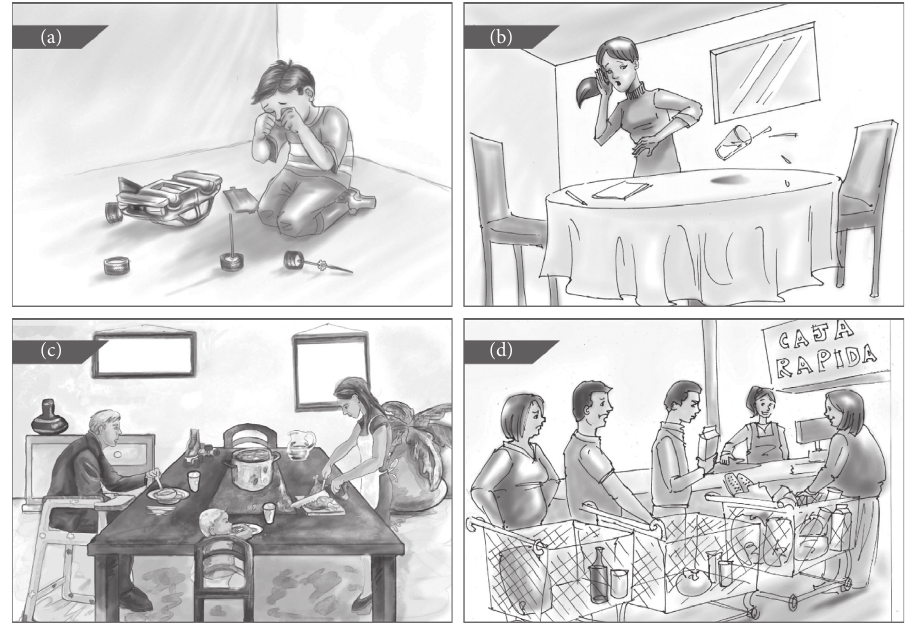
Figure 1: Examples of the COGSOC illustrations used in the causal relationships comprehension, absurdity identification, and social judgment ability subtests. The illustrations presented to patients are in color. (a) Causal relationships comprehension part A-causes: participants are asked “what has most probably happened immediately before this scene?” (b) Causal relationships comprehension part B- consequences: participants are asked “what has most probably happened immediately after this scene?” (c) Absurdity identification: participants are requested to find everything they consider wrong, nonsensical, or absurd. (d) Social judgment: in this item, participants were told “this is a fast cashier line and the lady at the front of the line has more items than that are permitted in her cart, what is the best course of action for the people in